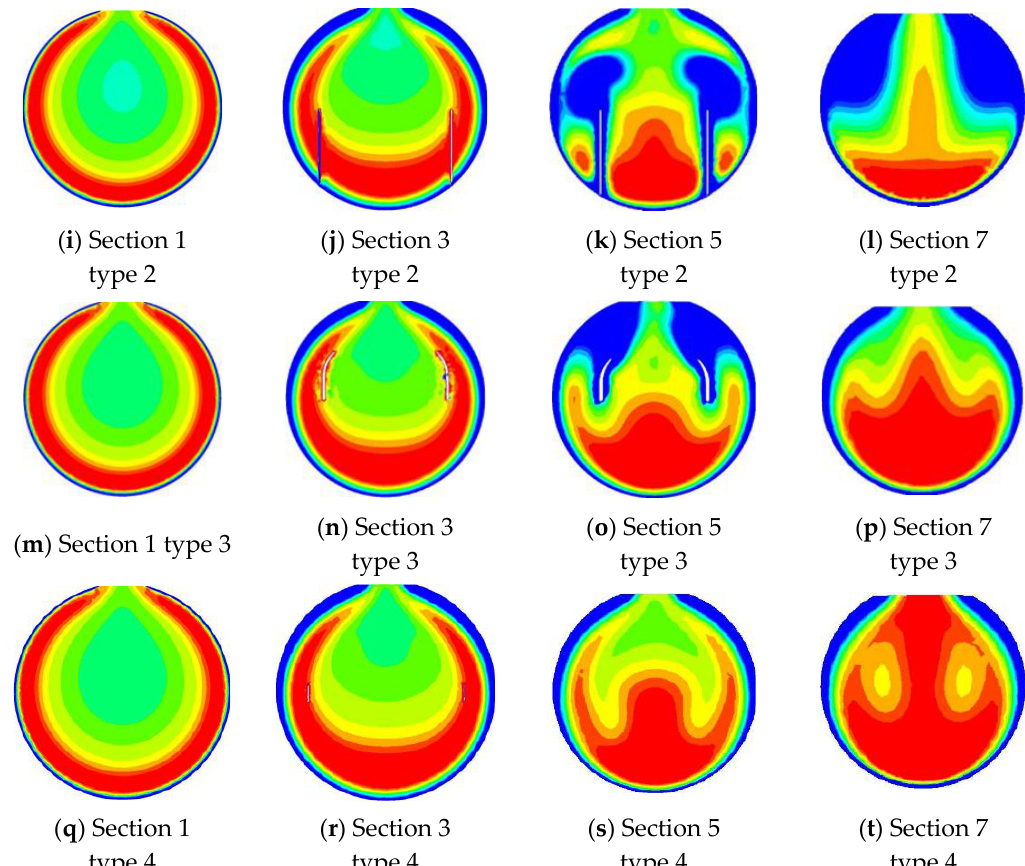
Figure 7. Distribution of the pressure field in the inlet pipe with various fin types.